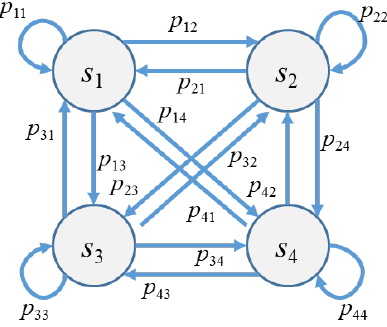
Figure 2. The 4-state Markov chain with 16 state-transition